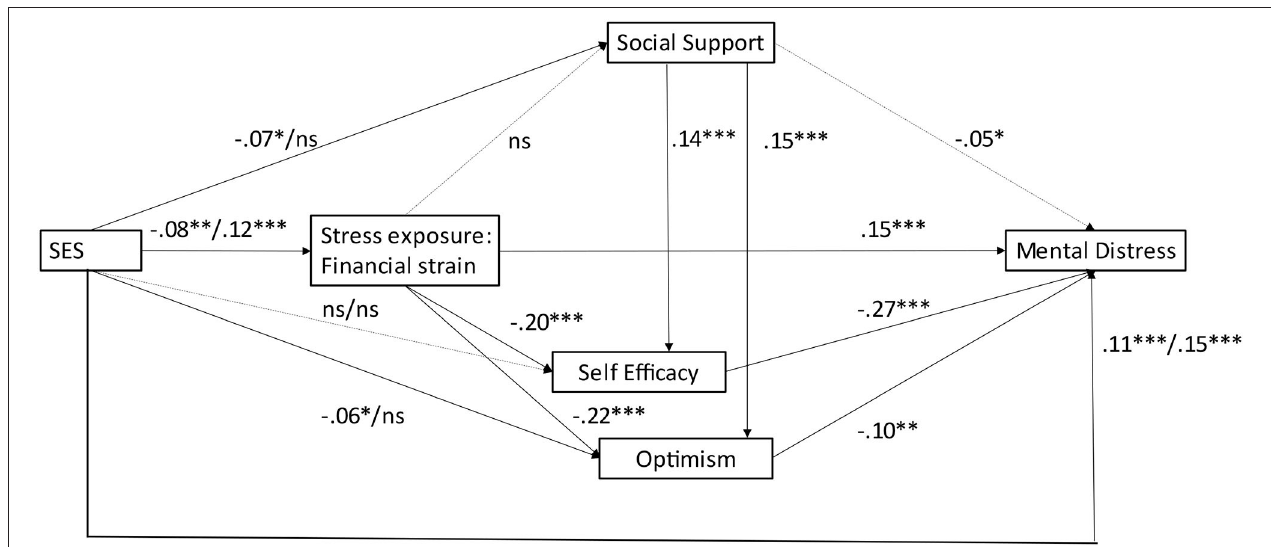
FIGURE 2 | Pathways linking SES, financial strain, psychosocial resource factors and mental distress (SEM estimates). SES effects are shown as: parental education/FSM; dotted lines are non-significant (ns). * p < 0.05, ** p < 0.01, *** p < 0.001.